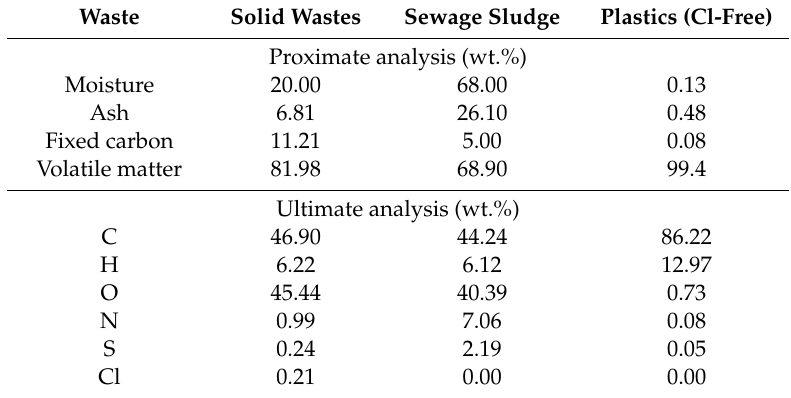
Table 2. Averaged proximate and ultimate analysis of the waste streams considered